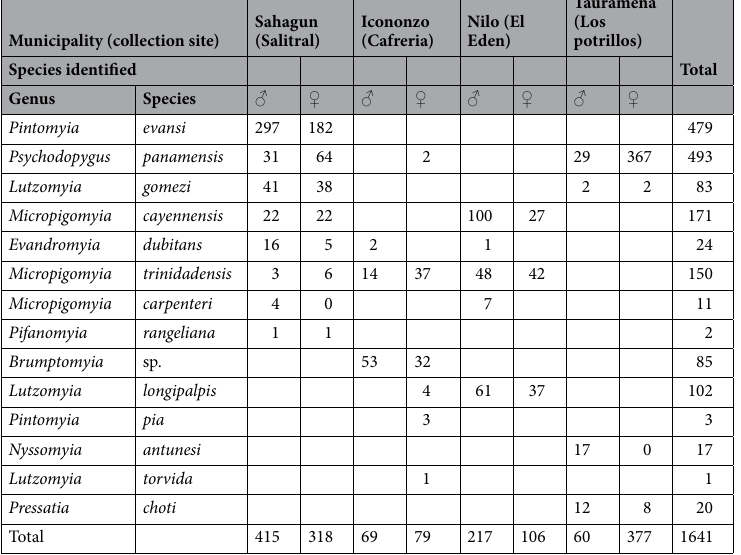
Table 1. Phlebotomine sand fly species identified in each collection site showing number of individuals